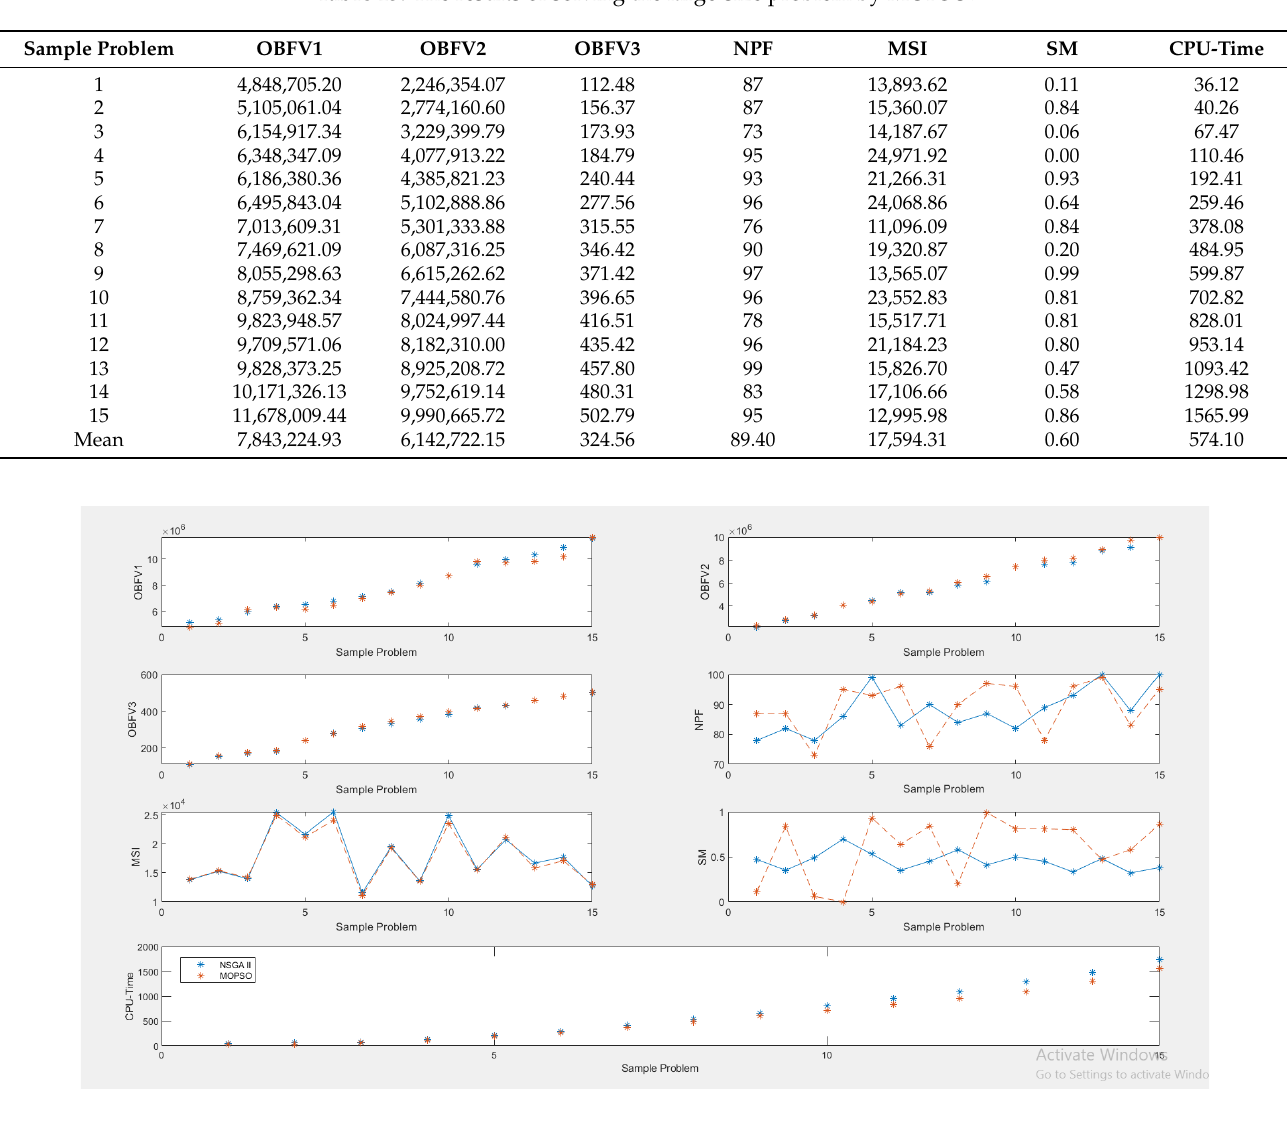
Table 13. The results of solving the large-size problem by MOPSO.